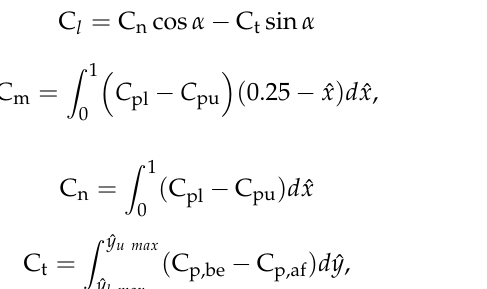
) , − p ) / ( 0.5 ρ U 2 C pi = ( p 0 i 0